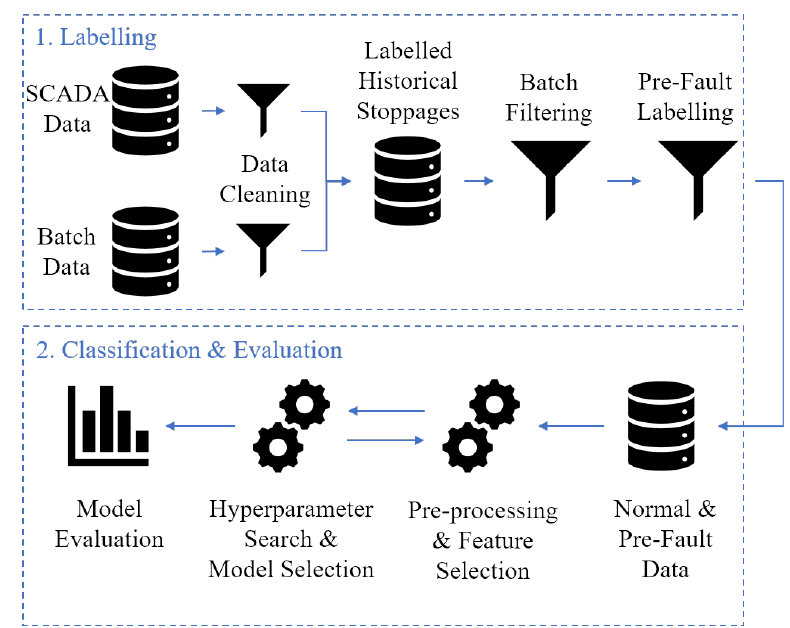
Figure 2. Overview of Classification